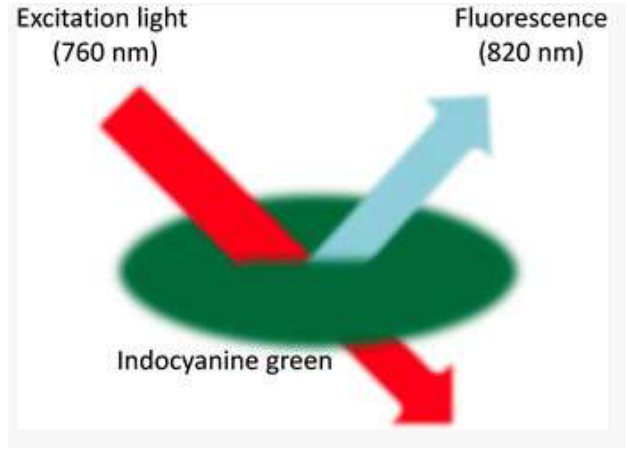
Figure 7. ICG fluorescence with a specific light wavelength (820 nm) in the near infrared spectrum